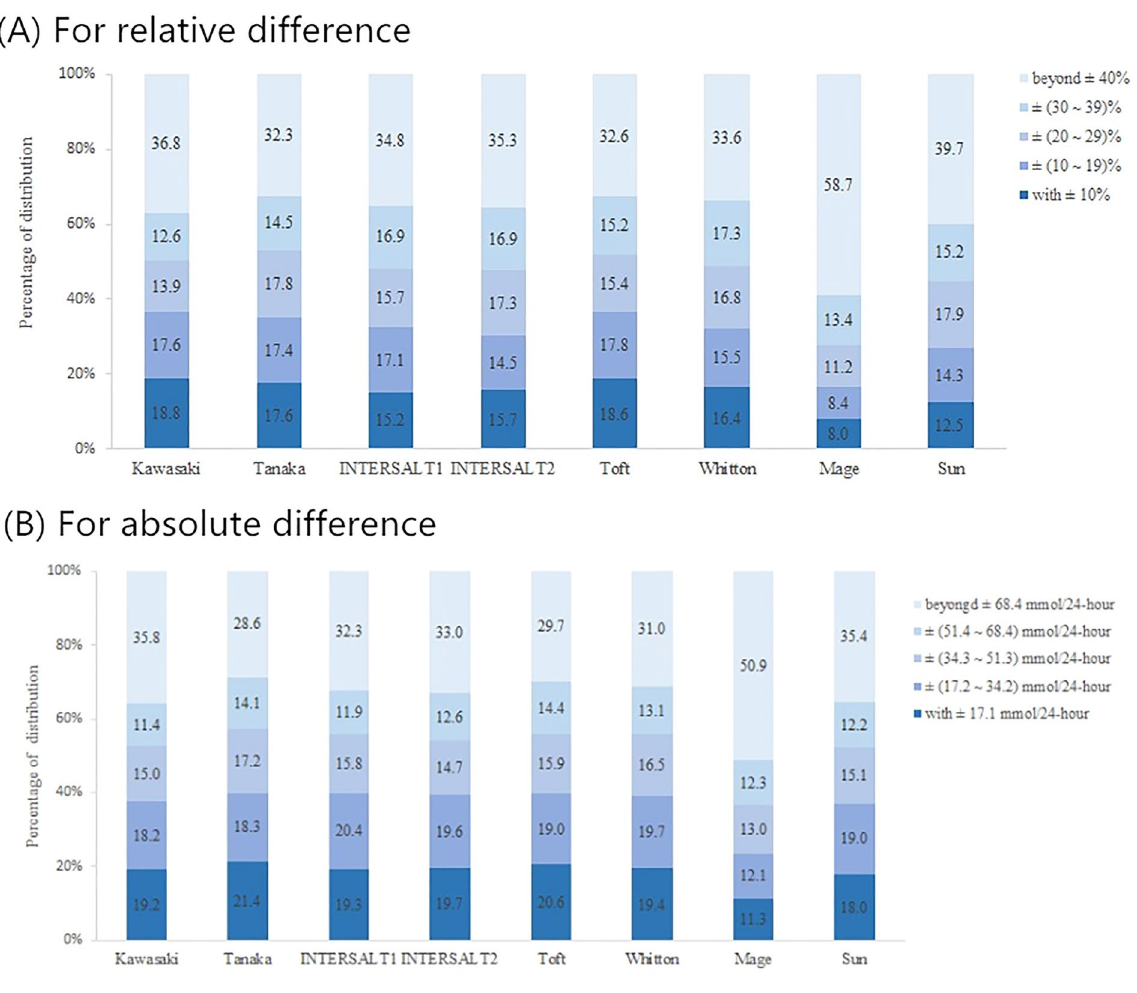
Figure 3. Relative and absolute difference distributions of 24-h urinary sodium excretion estimated based on eight equations. Relative difference ( A ) and absolute difference ( B